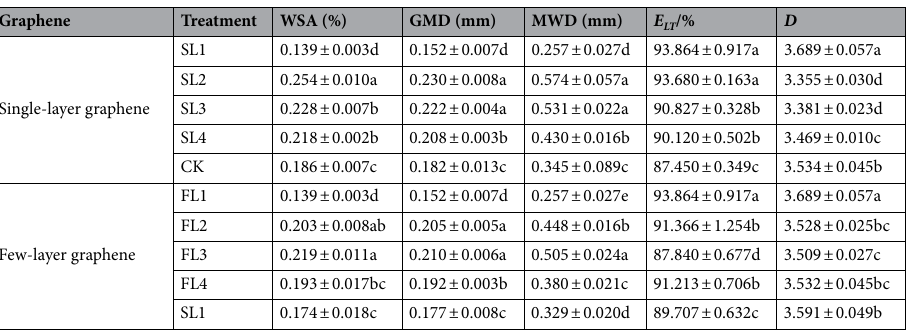
Table 2. Effect of different graphene concentration and type on soil water-stable aggregate stability indexes. WSA water stable aggregates, GMD geometric mean diameter, MWD mean weight diameter, E LT unstable aggregate index, D fractal dimension, CK. 0 g kg −1 single-layer graphene and 0 g kg −1 few-layer graphene; SL1 and FL1. 25 g kg −1 single-layer graphene and 25 g kg −1 few-layer graphene; SL2 and FL2. 50 g kg −1 single-layer graphene and 50 g kg −1 few-layer graphene; SL3 and FL3. 100 g kg −1 single-layer graphene and 100 g kg −1 few-layer graphene; SL4 and FL4. 150 g kg −1 single-layer graphene and 150 g kg −1 few-layer graphene; error bars indicate ± standard deviation. Different letters above error bars indicate significant difference between treatment ( p < 0.05, LSD test).